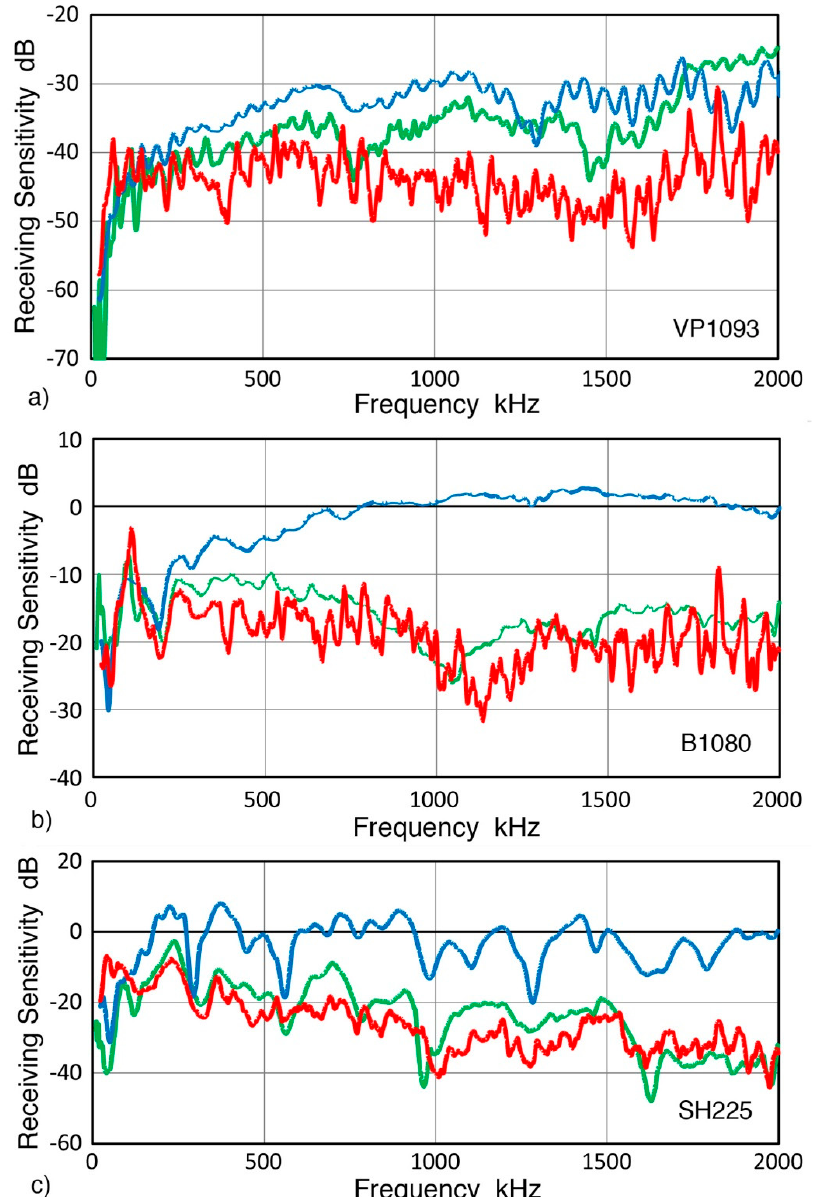
Figure 15. Receiving sensitivities of three AE sensors to three wave modes, NW (blue curves), RW (green curves), and GW (red curves). ( a ) VP-1093 sensor, ( b ) B1080 sensor, and ( c ) SH225 sensor.